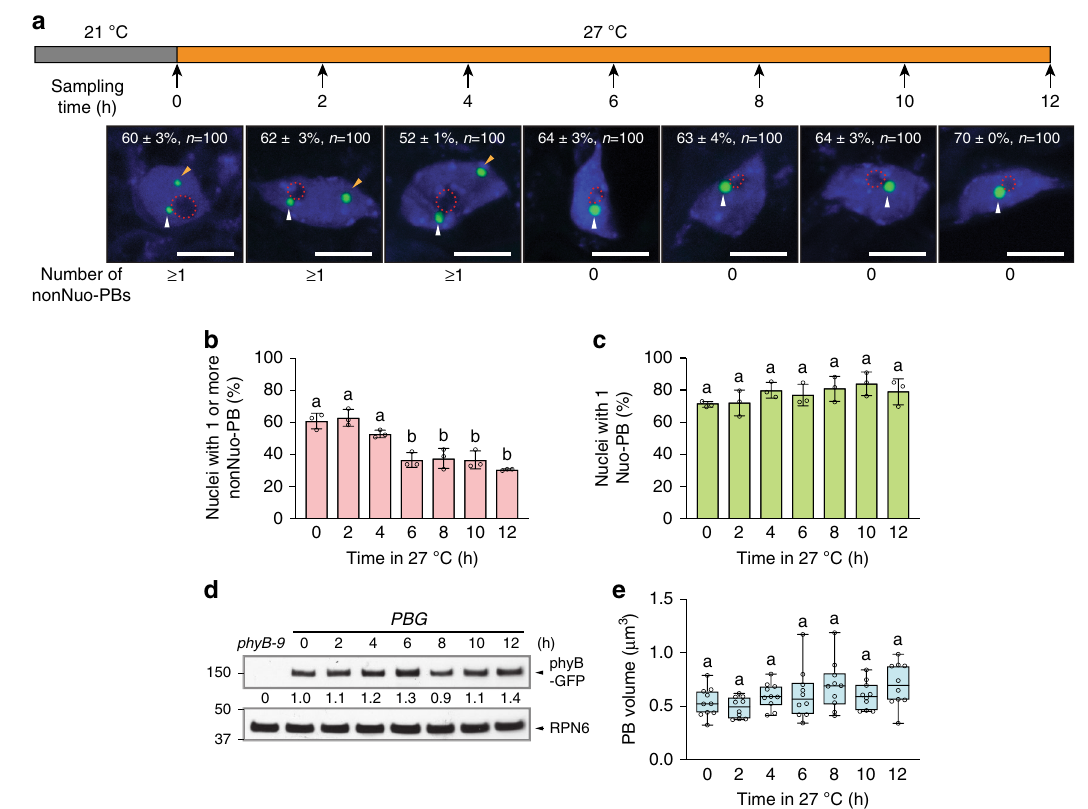
Fig. 4 Kinetics of warm temperature-induced disappearance of the nonNuo-PB in PBG . a Schematic illustration of the 21 to 27 °C transition experiment with maximum-projection, fl uorescence microscopy images showing representative steady-state patterns of phyB-GFP PBs in cotyledon epidermal-cell nuclei of 4-day-old PBG seedlings at the indicated time points. Nuclei were labeled by DAPI (blue), and the boundaries of the nucleoli are traced by red dashed lines. Nuo-PBs and nonNuo-PBs are indicated by white and orange arrowheads, respectively. The percentage of nuclei with s.e. showing the indicated PB pattern is included in each image; n indicates the total number of nuclei analyzed. Scale bars represent 5 μ m. b Quanti fi cation of the percentage of cotyledon epidermal-cell nuclei with one or more nonNuo-PB in the PBG seedlings described in a . c Quanti fi cation of the percentage cotyledon epidermal-cell nuclei with one Nuo-PB in the PBG seedlings described in a . For b , c , error bars represent s.e. calculated from groups of seedlings. Different letters denote statistically signi fi cant differences (ANOVA, Tukey ’ s HSD, P ≤ 0.05, n = 3). d Immunoblot results showing the levels of phyB-GFP in 4-day-old PBG seedlings grown under 10 µ mol m − 2 s − 1 R light in the indicated time points during the 21 to 27 °C transition. phyB-GFP was detected by anti-phyB antibodies, and RPN6 was used as a loading control. phyB-9 was used as a negative control. The relative levels of phyB-GFP normalized against the corresponding levels of RPN6 are shown below the phyB-GFP immunoblot. e Quanti fi cation of the volume of PBs in cotyledon epidermal-cell nuclei of the PBG seedlings during the 21 to 27 °C transition described in a . The boxes represent from the 25th to the 75th percentile, and the bars equal the median values. Samples with the same letter exhibit no statistically signi fi cant difference in PB volume (ANOVA, Tukey ’ s HSD, P ≤ 0.05, n = 10). The source data underlying the PB measurements in b , c , e , and the immunoblots in d are provided in the Source Data fi